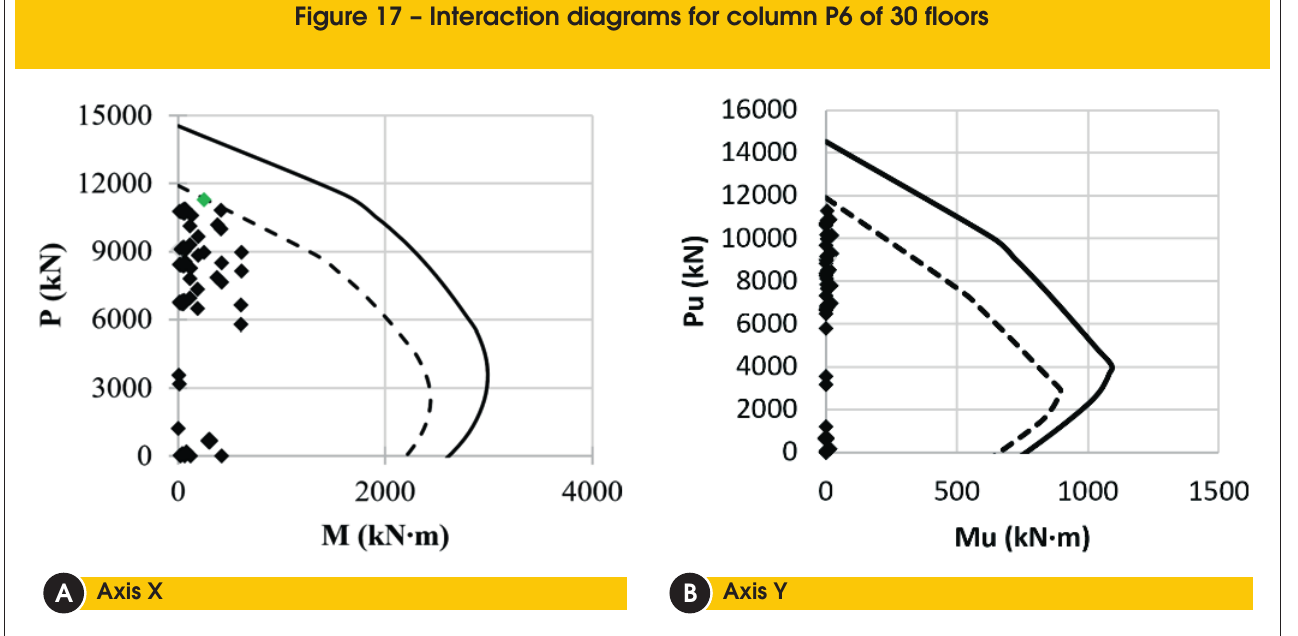
Figure 17 – Interaction diagrams for column P6 of 30